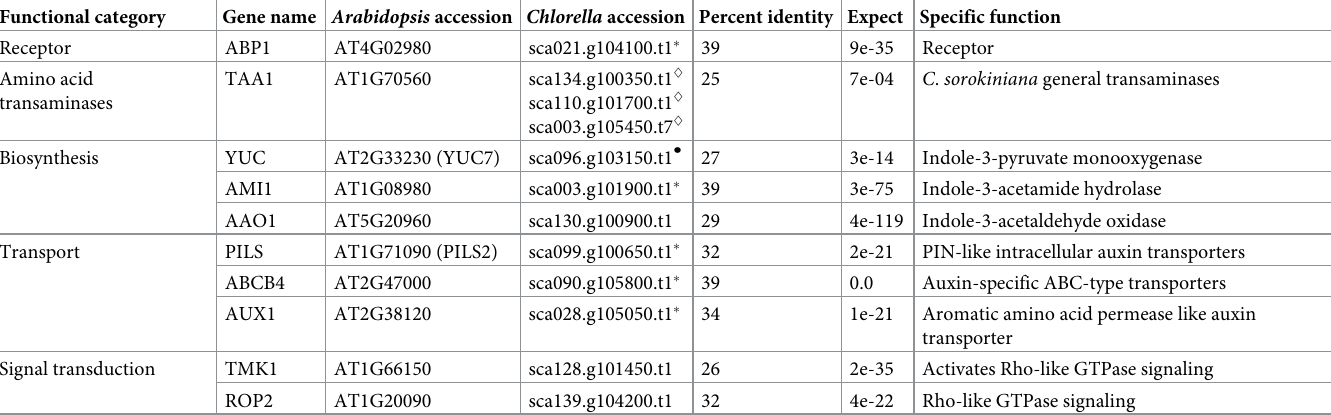
Table 1. The Chlorella sorokiniana genome encodes putative orthologs for the biosynthesis, transport, sensing, and signal transduction of auxin. Functional